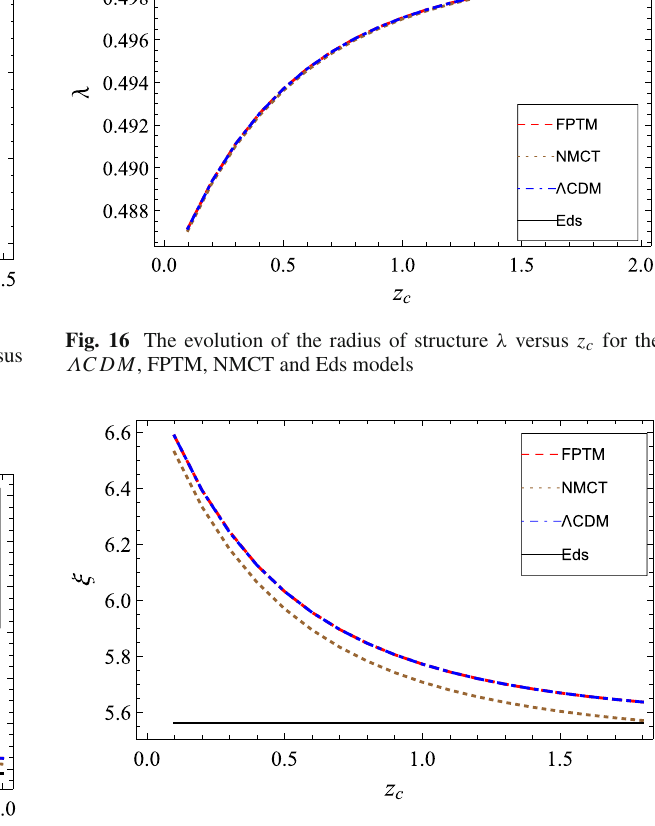
Fig. 17 The evolution of the ξ parameter versus z c for the Λ CDM , FPTM, NMCT and Eds